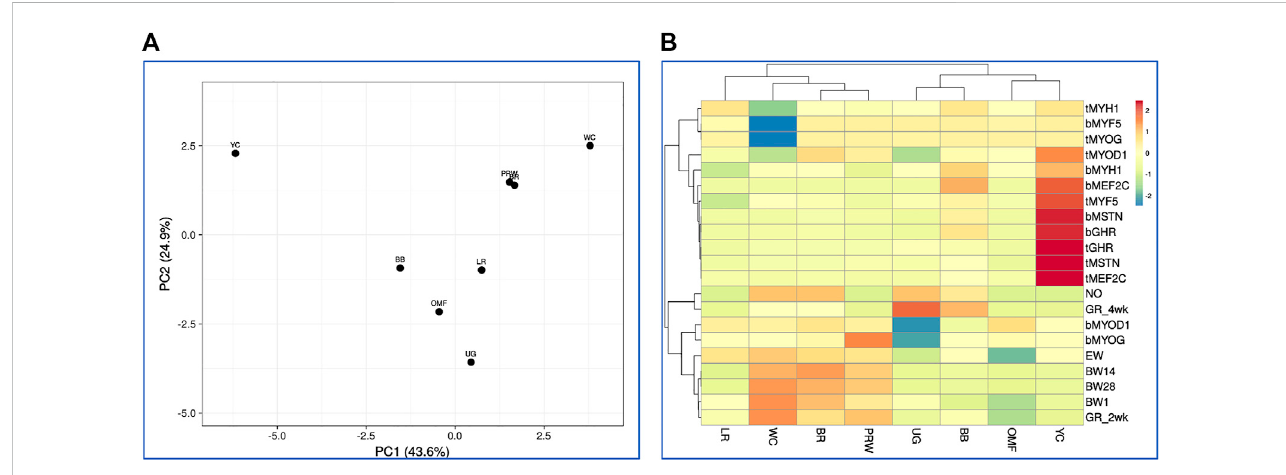
FIGURE 8 Distribution of the eight breeds based on the analysis of relationships between 21 traits (DGE of myogenesis associated genes and NO metabolism in embryos, as well as indicators of early chick growth) as performed in the ClustVis program (Metsalu and Vilo, 2015). (A) PCA plot. Unit variance scaling was applied to rows; singular value decomposition with imputation was used to calculate principal components. X and Y -axes show principal component 1 (PC1) and principal component 2 (PC2) that explain 43.6% and 24.9% of the total variance, respectively. N = 8 data points (breeds). (B) Heatmap and clustering trees using Euclidean distances (with the average option selected as linkage method).